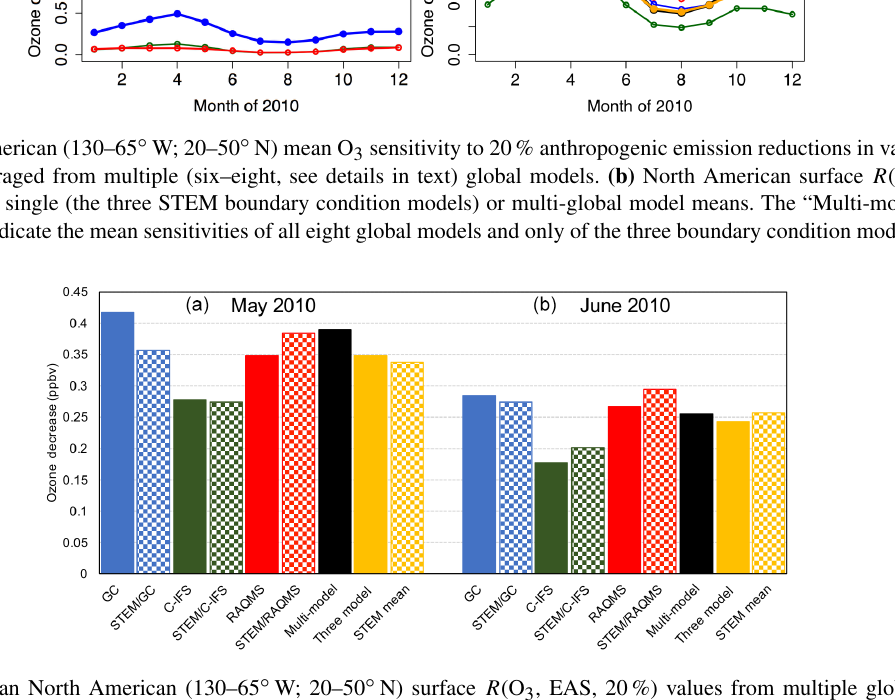
Figure 7. Monthly mean North American (130–65 ◦ W; 20–50 ◦ N) surface R (O 3 , EAS, 20%) values from multiple global and regional model simulations for (a) May and (b) June 2010. STEM model mean values were calculated from its hourly output from 8 May and on. The “Multi-model” and “Three model” in the legend indicate the mean sensitivities of all eight global models and only of the three boundary condition models,